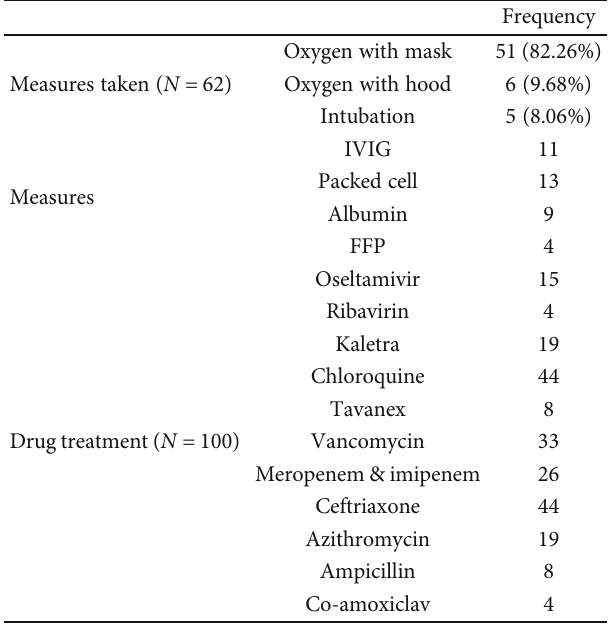
Table 2: Therapeutic modalities of admitted children with COVID- 19 ( N = 100